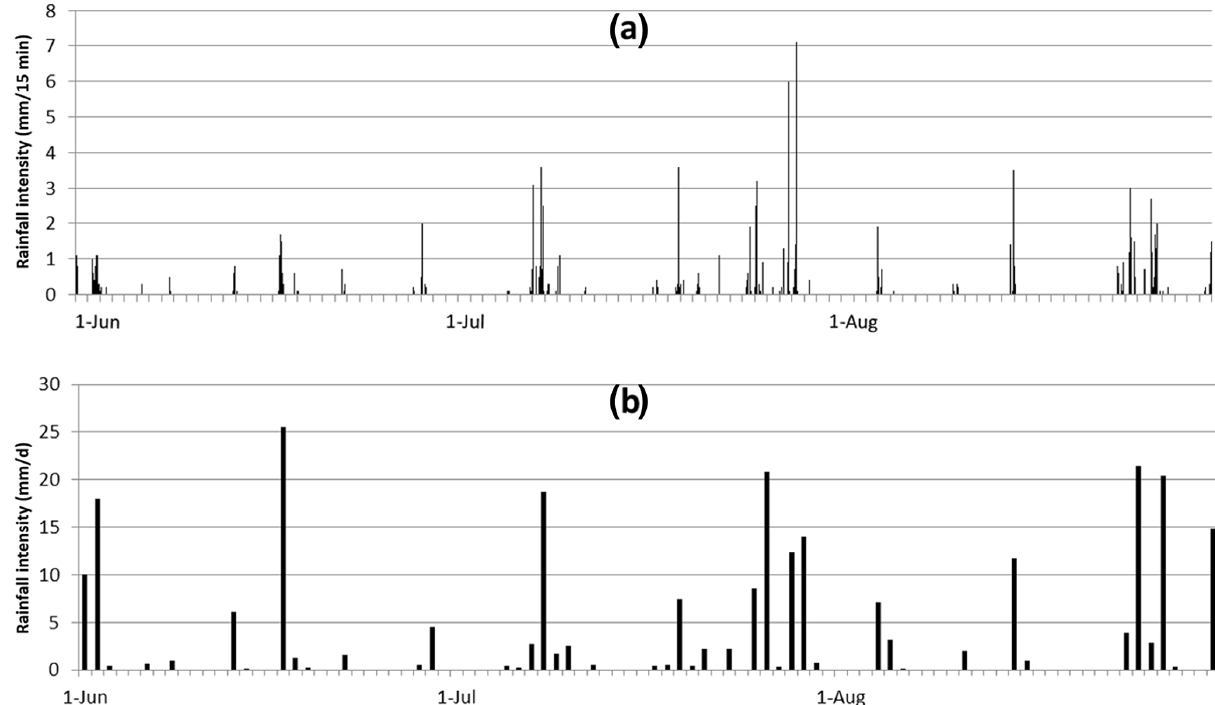
Figure 9. Rainfall time series in the SMHI gauge at 15min (a) and 1d (b) temporal resolution.